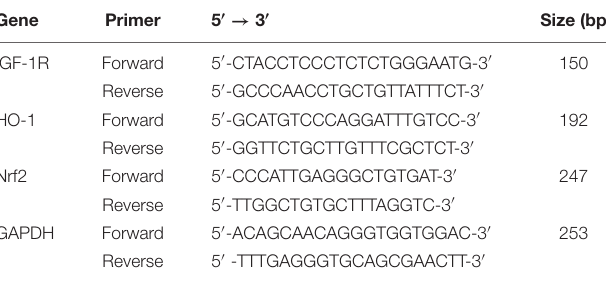
TABLE 1 | Primer sequences designed for RT-PCR.